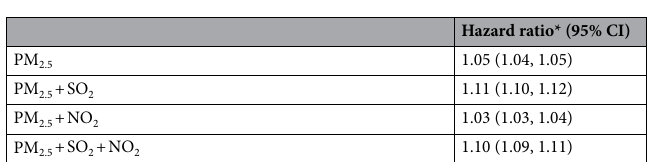
Table 3. Hazard ratios (95% CI) for the association between PM 2.5 and dementia risk during the 13-year follow-up period. Adjusted for age, sex, modified CCI, hypertension, diabetes, hyperlipidemia, temperature, relative humidity and pollutants in the corresponding year.